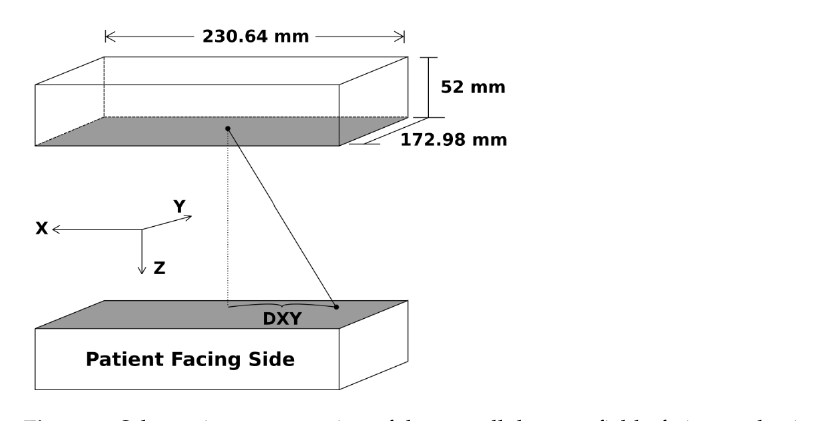
Figure 4. Schematic representation of the overall detector field of view and axis convention.